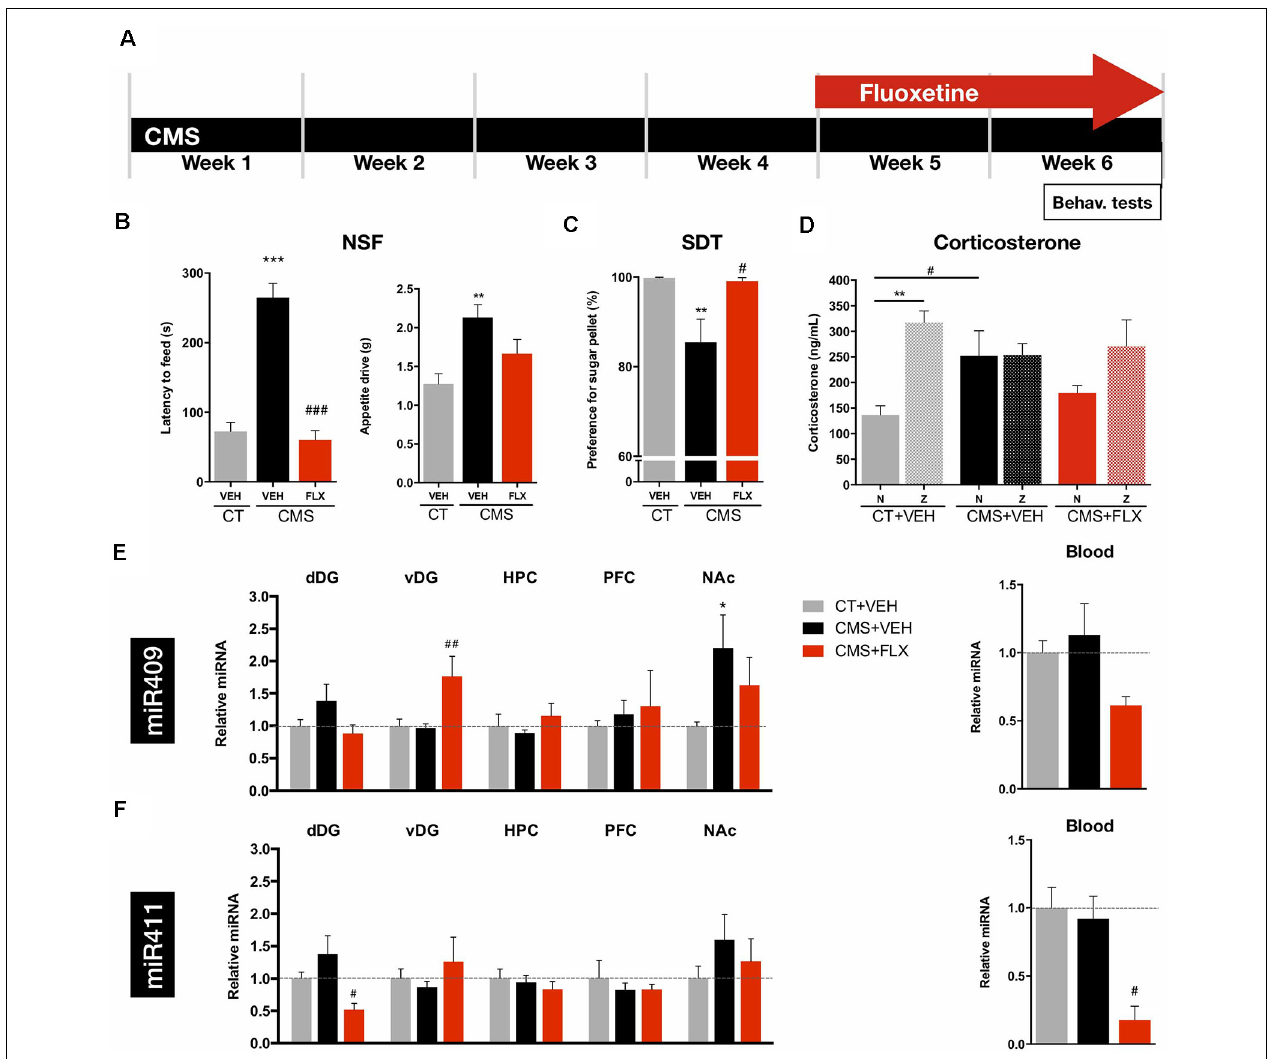
FIGURE 1 | Behavioral analyses and miRNA levels after CMS exposure and fluoxetine treatment. (A) CMS protocol was applied for 6 weeks and fluoxetine treatment was performed during the last 2 weeks. Behavioral analyses and blood collection were performed at the end of the CMS protocol. (B) Novelty suppressed feeding (NSF) test was applied to evaluate anxiety-like behavior; left panel: latency to feed and right panel: appetite drive. (C) Sweet Drive Test (SDT) was used to assess anhedonia. (D) Corticosterone levels measured in the blood serum of rats between 8:00 and 9:00 (basal levels, Nadir, N) and between 20:00 and 21:00 (peak levels, Zenith, Z). (E) Relative levels of miRNA-409-5p in the dorsal (dDG) and ventral dentate gyrus (vDG), CA regions of the hippocampus (HPC), prefrontal cortex (PFC), nucleus accumbens (NAc), and in the blood. (F) Relative levels of miR-411-5p in the dDG, vDG, HPC, PFC, NAc, and in the blood. *Denotes differences between CT and CMS; # Denotes differences between CMS+VEH and CMS+FLX. Abbreviations: CT, Control; CMS, unpredictable chronic mild stress; NSF, Novelty Suppressed Feeding test; SDT, Sweet Drive test. Data presented as mean ± SEM. FLX, fluoxetine; N, Nadir; Z, Zenith. ∗ / # p < 0.05; ∗∗ / ## p < 0.01; ∗∗∗ / ### p < 0.001.